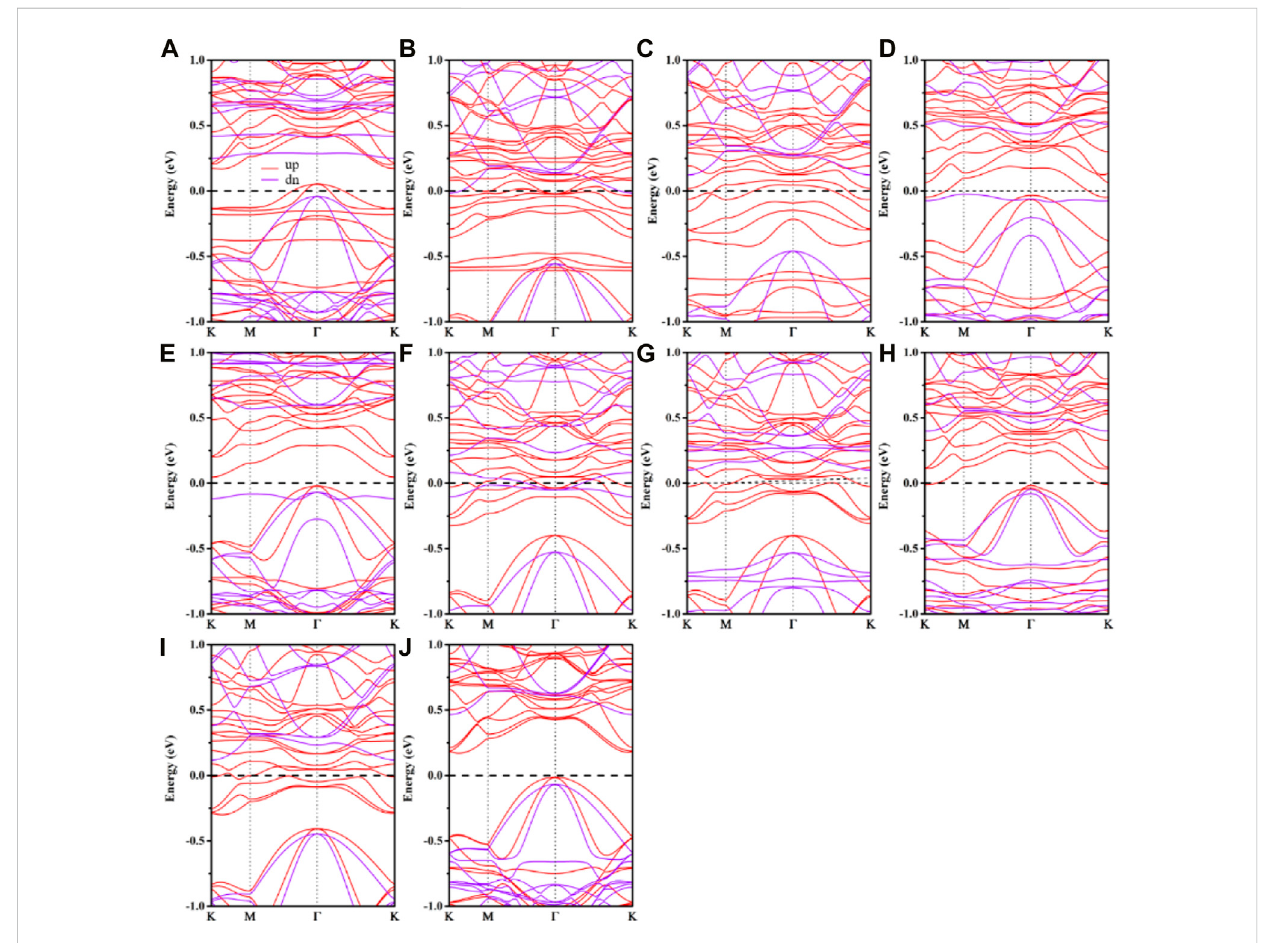
FIGURE 3 The calculated spin-polarized band structures of (A) Cr 2 G 2 Te 6 @Sc, (B) Cr 2 G 2 Te 6 @Ti, (C) Cr 2 G 2 Te 6 @V, (D) Cr 2 G 2 Te 6 @Cr, (E) Cr 2 G 2 Te 6 @Mn, (F)